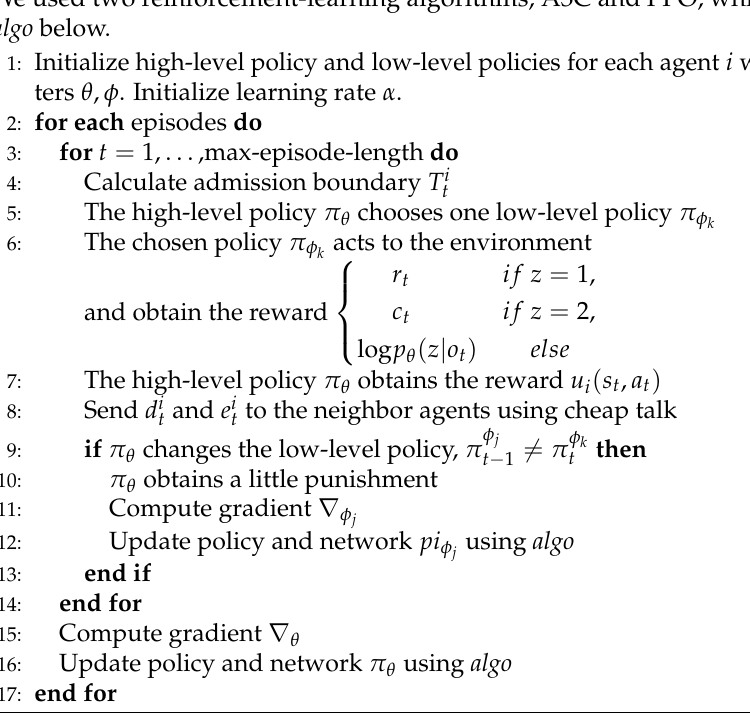
Algorithm 1 Admission algorithm